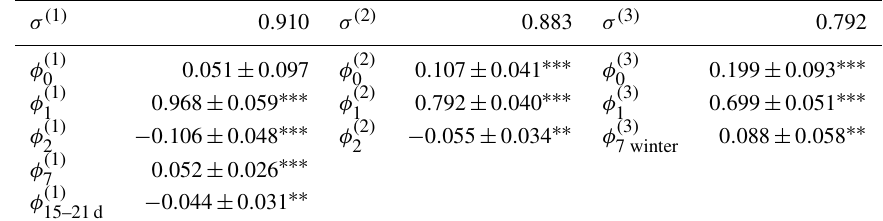
Figure 7. Plots of the ability of the extended SDNAR (ESDNAR) (a, b) and extended SETAR (ESETAR) (c, d) models to reproduce the higher moments and sample ACF of the daily NAO winter index. The plots are generated in the same way as the plots in Fig. 5. Table 3. Parameter estimates for an ESETAR model for the daily winter NAO index.